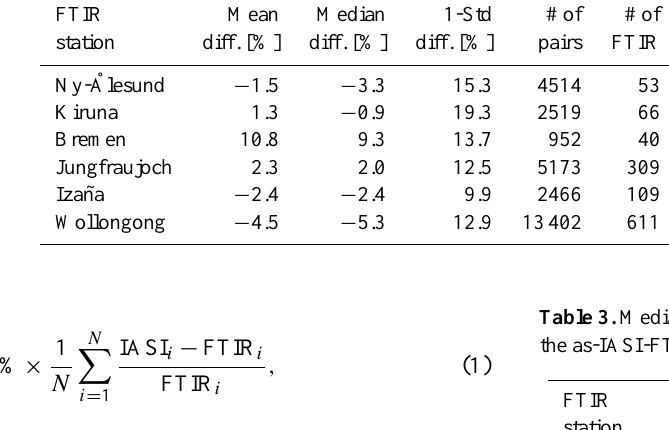
Table 2. Results of the CO total column comparisons between IASI and the as-IASI-FTIR data. The mean and median differences and the 1- σ standard deviation are indicated in columns 2 to 4, the number of individual comparisons, of unique FTIR values and of unique IASI values in columns 5 to 7, the number of days in column 8, the correlations, R , between the individual column values in column 9 and the maximum temporal coincidence (hours and minutes), max 1t , in column 10. FTIR Mean Median 1-Std # of # of # of # of R Max station diff. [%] diff. [%] diff. [%] pairs FTIR IASI days 1t Ny- ˚Alesund